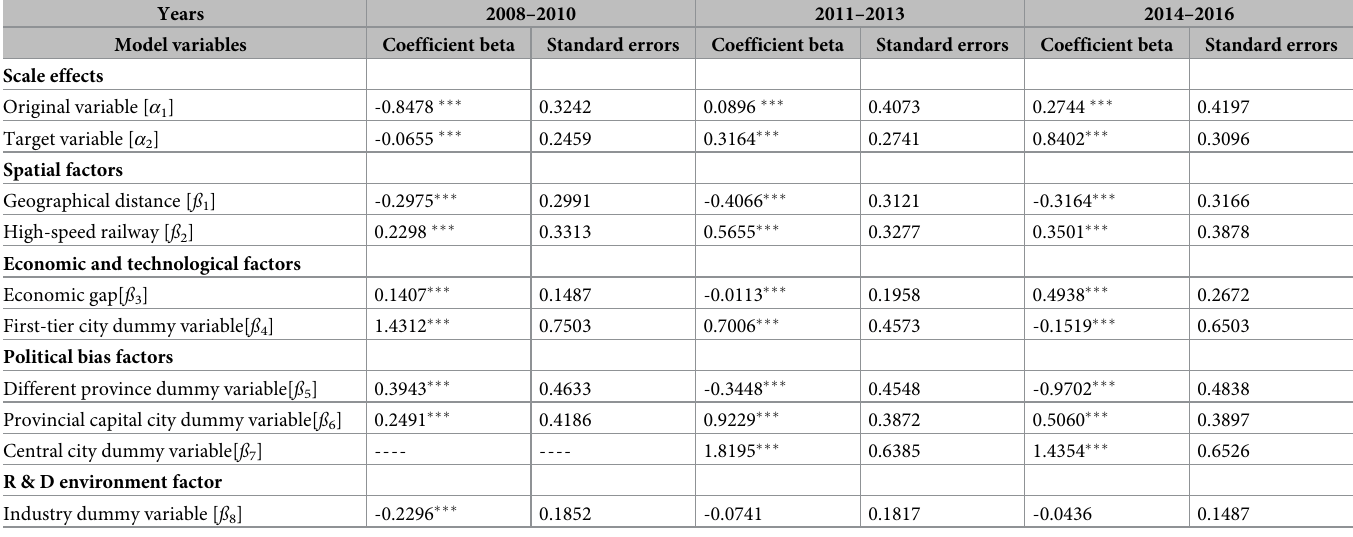
Table 14. Estimation results of the negative binomial spatial interaction model, based on common patents among cities in Yangtze River Delta urban agglomeration.